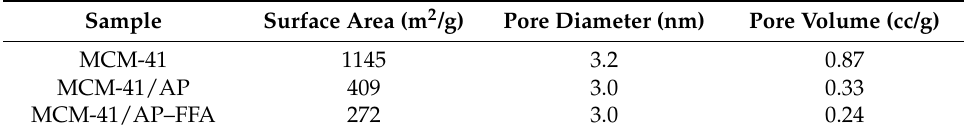
Table 1. Data of surface area, pore diameter, and pore volume, before and after functionalization of MCM-41 with 3-Aminopropyltriethoxysilane (APTES) and flufenamic acid (FFA) from N 2 adsorption results.